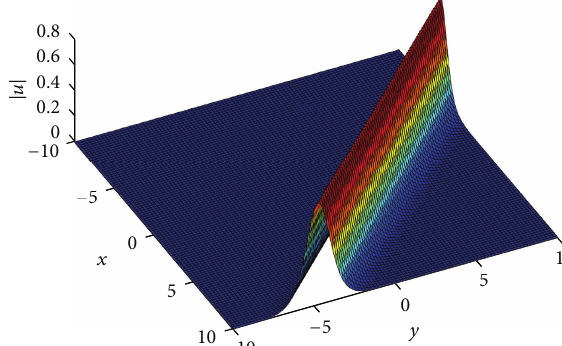
Figure 6: Soliton solution |𝜙| 2 at 𝑡 = 1 .